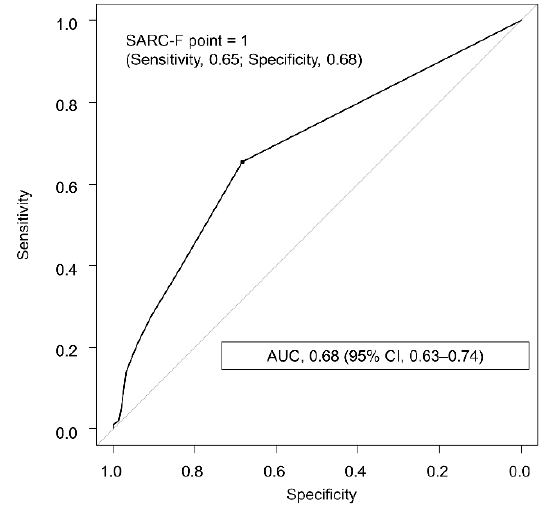
Figure 2. Receiver operating characteristic curve of the SARC-F for identifying sarcopenia in patients with chronic liver disease. The optimal cutoff value was determined using the highest Youden index value. AUC, area under the receiver operating characteristic curve.